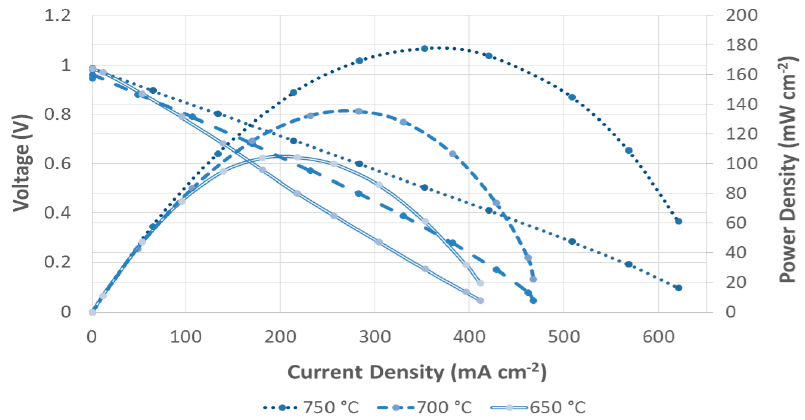
Figure 12. The I – V and I – P curves of the cell.